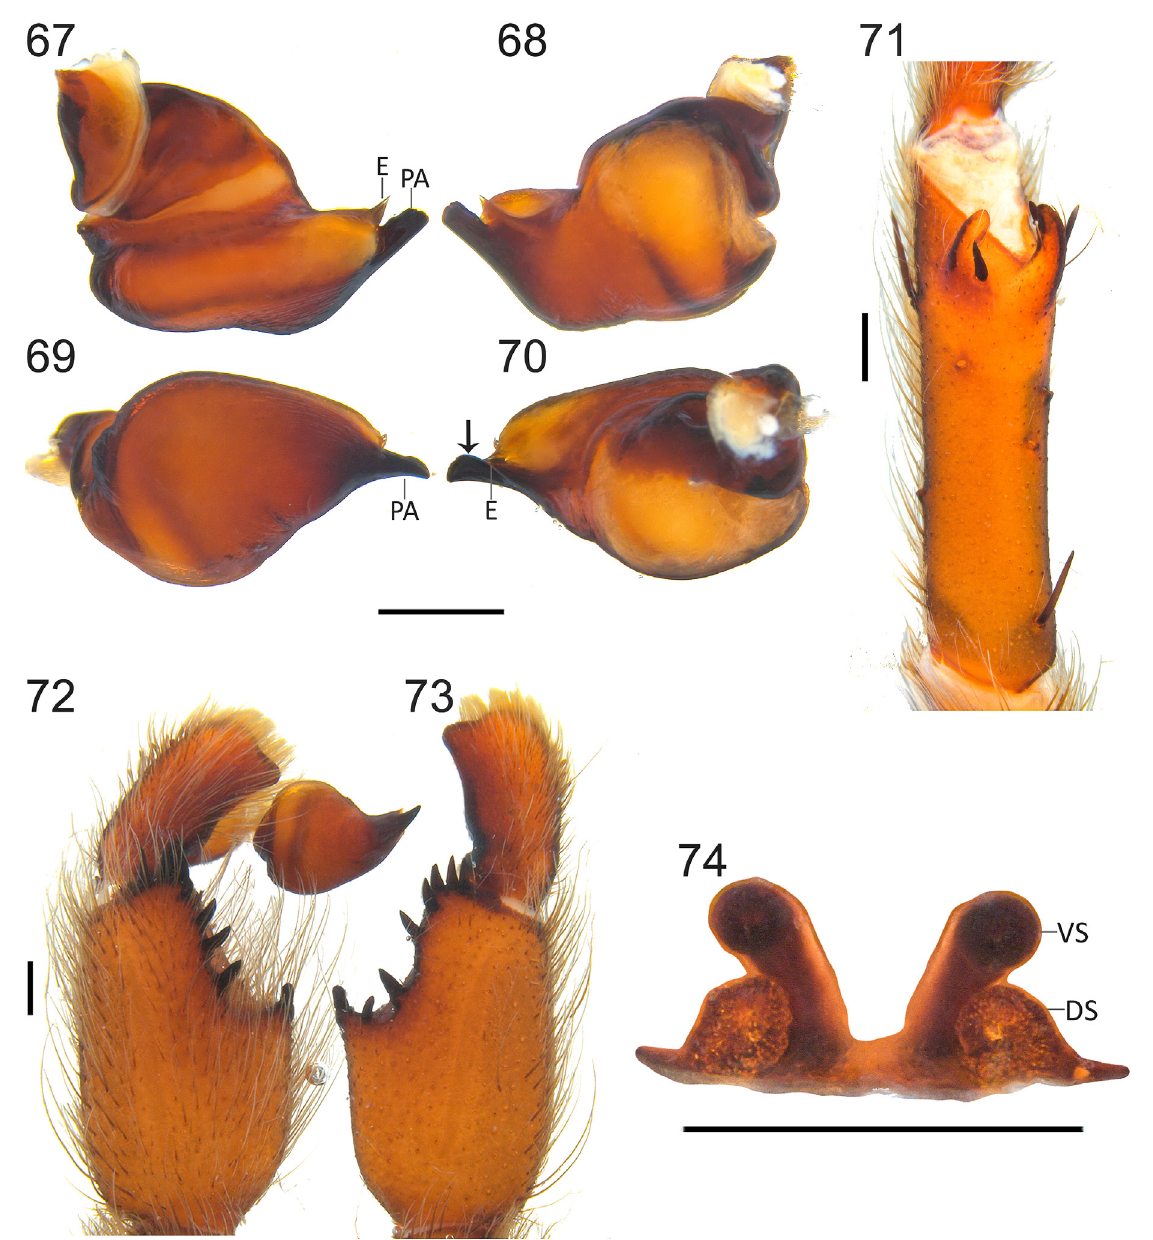
Figs 67–74 . Schismatothele timotocuica sp. nov. 67–73 . Holotype, ♂ (MZSP 28420). 67–70 . Palpal bulb, prolateral (67), retrolateral (68), ventral (69), and dorsal (70) views. 71 . Tibial spur, ventral view. 72–73 . Palpal tibiae, right (72), and left (73). 74 . Paratype, ♀ (MZSP 26081), permathecae, ventral view. Abbreviations: E = embolus; DS = dorsal receptacle; PA = paraembolic apophysis; VS = ventral receptacle. Black arrow show the retrolateral torsion of paraembolic apophysis. Scale bars = 0.5